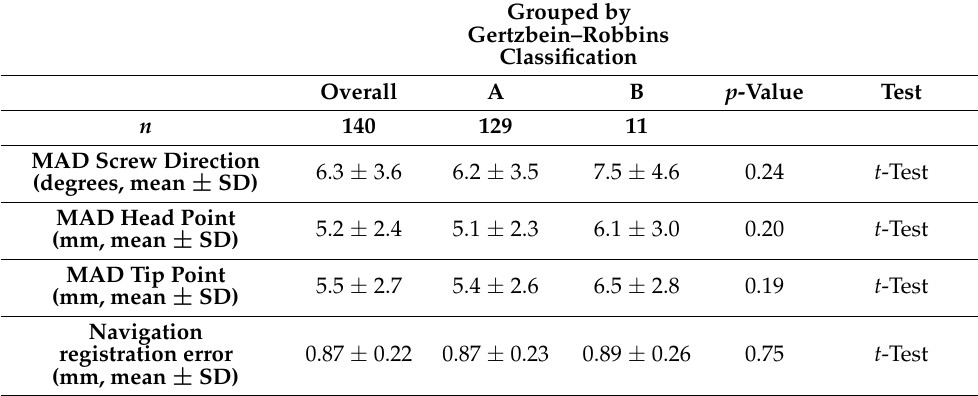
Table 2. Three-Dimensional Quantitative Analysis of Screw Accuracy and Confounders of Qualitative Screw